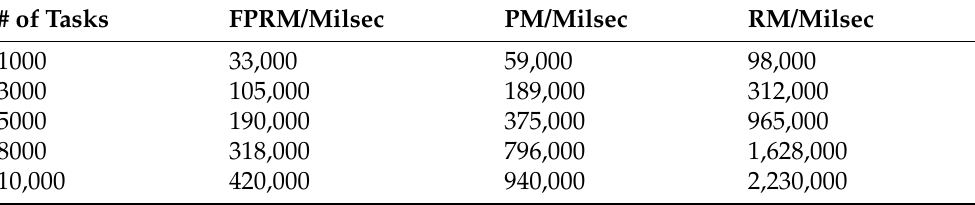
Table 4. Simulation results of the proposed algorithm’s run time in different